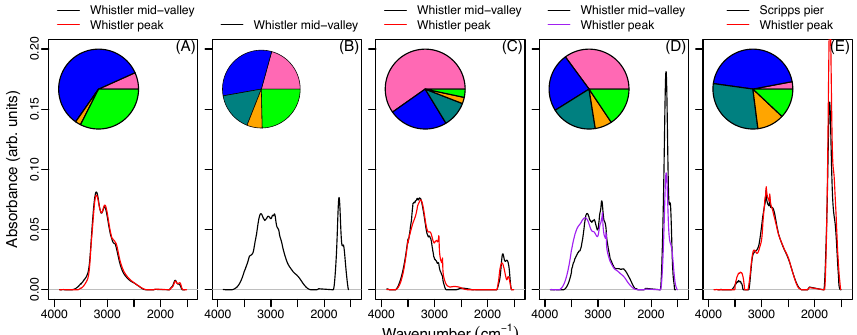
Fig. 10. PMF factors of FTIR spectra from Whistler peak and other studies, with pie graphs showing OFG composition using the color scheme in Fig. 9. (A) Anthropogenic combustion factors from Whistler mid-valley (black; Schwartz et al., 2010) and Whistler peak 3- factor solution (red; nearly identical to 2-factor solution). (B) (non-burning) combined biogenic factor from Whistler mid-valley study. (C) Biogenic Factor Part 1 from Whistler mid-valley study (black), and Whistler peak Factor Bio (red). (D) Biogenic Factor Part 2 from Whistler mid-valley study (black), and Whistler peak forest factor from 2-factor solution (purple). (E) biomass burning factor from Scripps Pier study (black; Hawkins and Russell, 2010) in San Diego, CA, and Factor BB from Whistler peak study (red). and 23 % for category (d), respectively (Figs. 9b 0 and d 0 ).